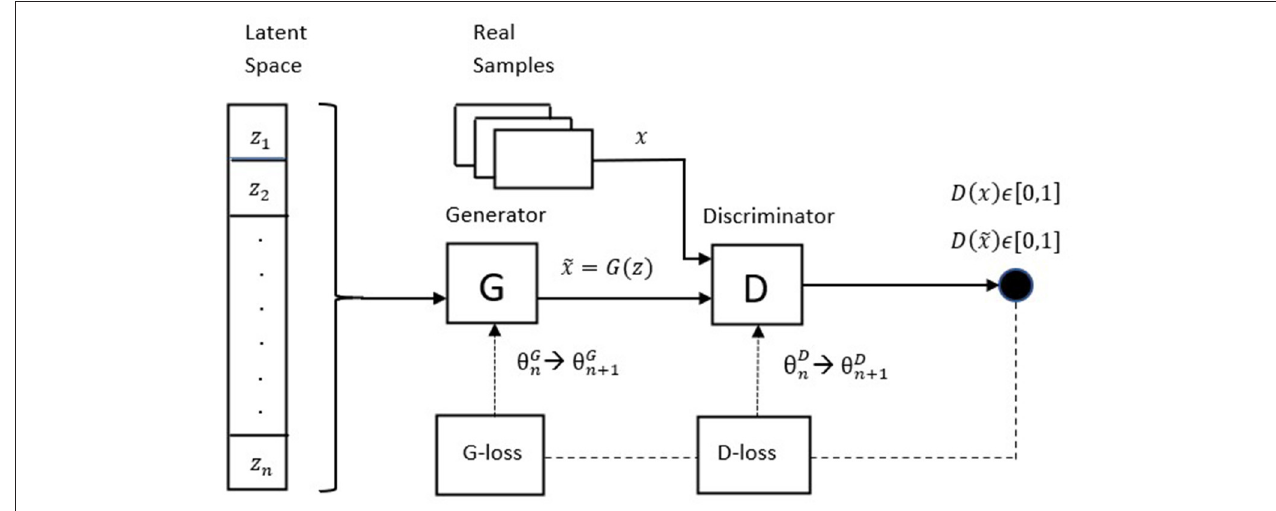
FIGURE 1 | Stylized architecture of the original